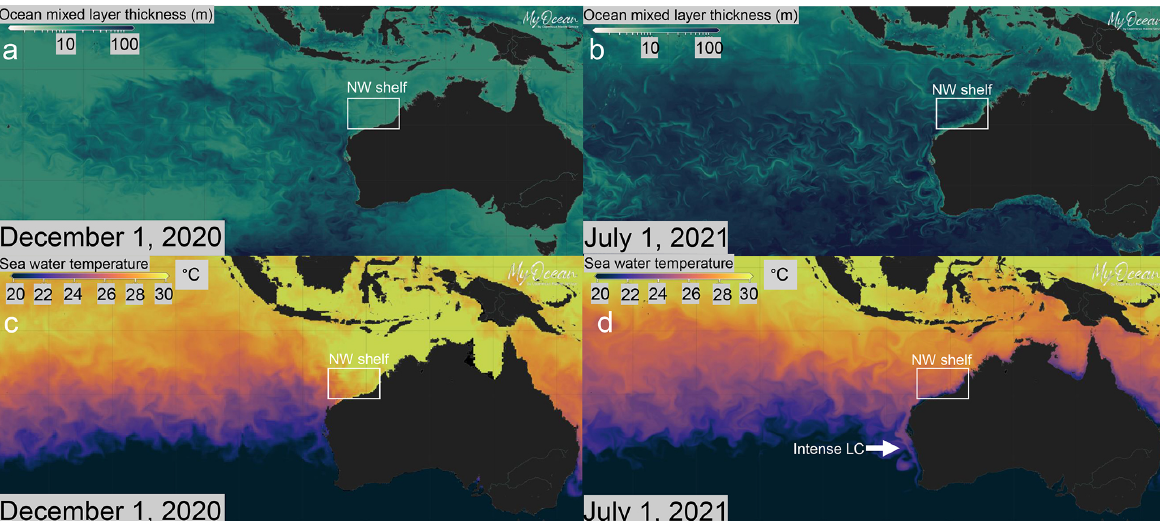
Figure 2. Present-day ocean circulation maps of the southeastern Indian Ocean area for 1 December 2020 (austral summer; a , c ) and 1 July 2021 (austral winter; b , d ). The LC is weak during austral summer, causing (a) reduced depth of the mixed layer and increased stratification and (c) higher sea surface temperature (SST) over the NW Australian shelf. The LC intensifies during austral winter, when (b) water column mixing in the eastern Indian Ocean increases and (d) SST decreases in the NW Australian shelf area; at the same time, it transports warmer surface waters further to the south (d) . The sea surface cooling effect observed in shelf environments during July is less pronounced further offshore. Maps were generated using the ocean data visualisation tools of EU Copernicus Marine Service Informa- tion (MyOcean Pro) and the dataset layers GLOBAL_ANALYSIS_FORECAST_PHY_001_024 (https://doi.org/10.48670/moi-00016) and